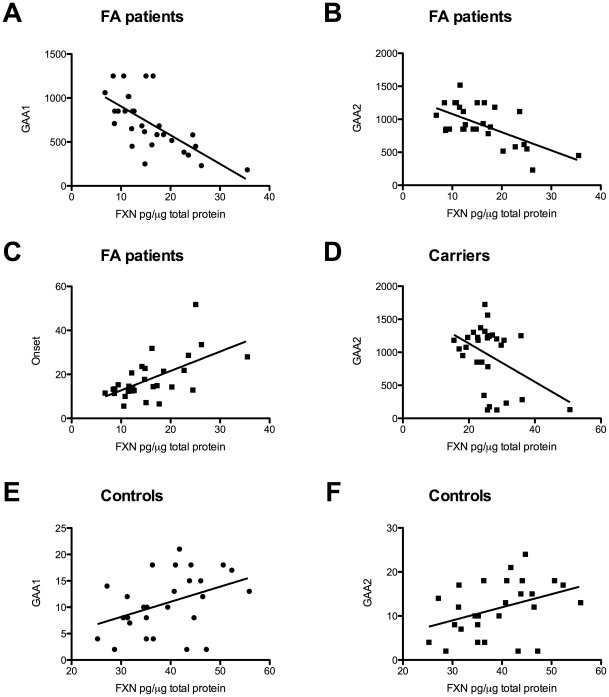
Protein correlation analysis.A) correlation between frataxin levels and GAA1 repeats in cFA and LOFA pateints (p<0.0001, R2 = 0.4632); B) correlation between frataxin levels and GAA2 repeats in cFA and LOFA patients (p<0.001, R2 = 0.3886); C) correlation between frataxin levels and age at onset for cFA and LOFA (p<0.001, R2 = 0.3577); D) correlation between frataxin and GAA2 in carriers (p<0.05, R2 = 0.1745); E) correlation between frataxin levels and GAA1 in controls (p<0.05, R2 = 0.1634); F) correlation between frataxin levels and GAA2 in controls (p<0.05, R2 = 0.1463).